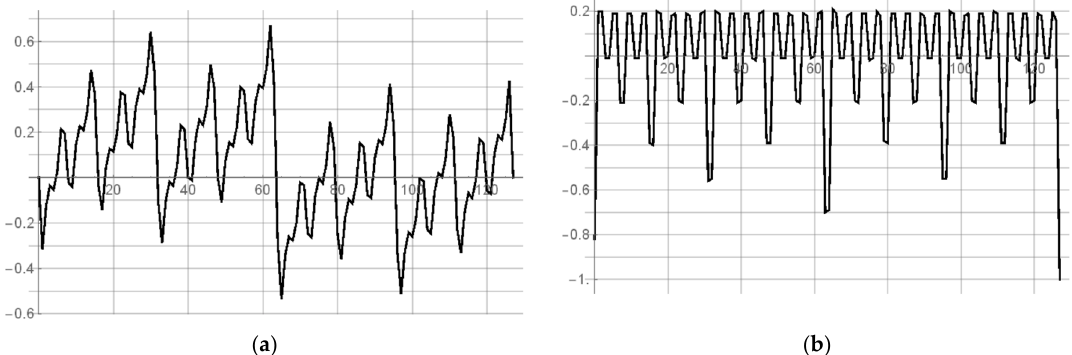
Figure 32. ( a ) INL normalized to LSB ( b ) DNL normalized to LSB for code words at 8-bit SA-TDC and T m = 350 ps.